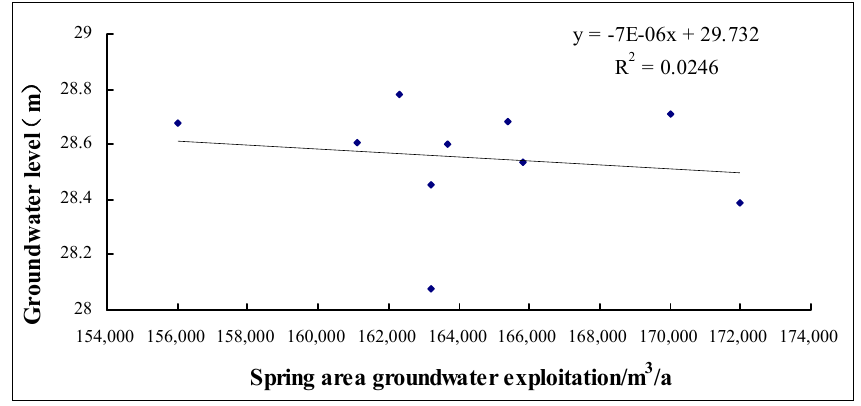
Figure 11. Relationship between groundwater exploitation and spring water level, 2003–2012.